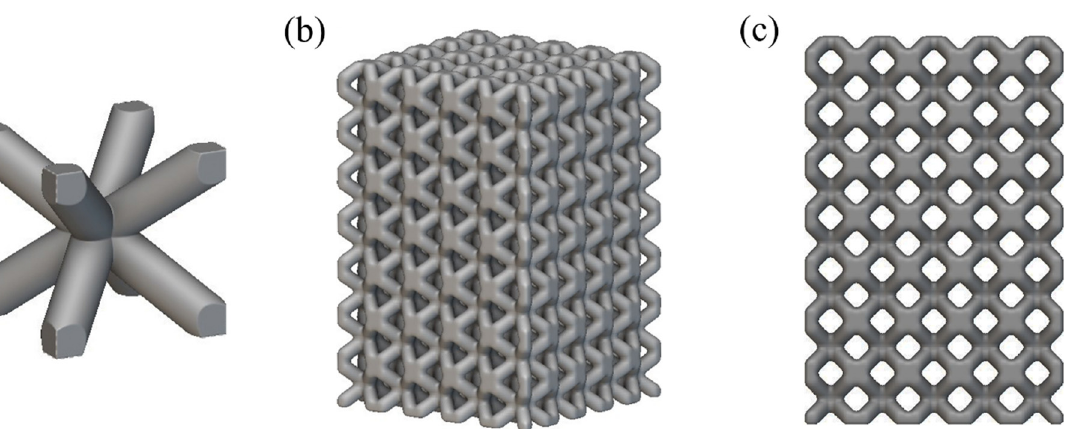
Figure 4. Fabrication of 316L metallic lattice structure and epoxy/316L metallic lattice structure. Figure 5a,b are the secondary electron micromorphology of the epoxy/316L metal lattice composites. There are no defects such as cracks or incomplete fusion, only small ‐ sized pores. Figure 5c,d show the interface contact between the epoxy and the metal. The interface is generally well bonded, but bubbles are easily generated at the interface, re ‐ sulting in incomplete bonding of the interface. Figure 5e,f are the molding quality of the epoxy; the overall molding is good, but there are local bubbles that are not exhausted. Table 1 shows the damping properties of the 316L metallic lattice structure and the epoxy/316L metallic lattice composites. The damping ratio of the 316L metallic lattice structure is 0.99743%, which is much higher than that of the 316L metal matrix [31], which is about 10 times higher than the base, indicating that the structural design can effectively improve damping performance. The porosity of the lattice structure exceeds 50%. Through the filling of epoxy, the pore part is occupied by epoxy, and the damping ratio of the epoxy/316L metallic lattice composites has been greatly improved, reaching 13.31156%.